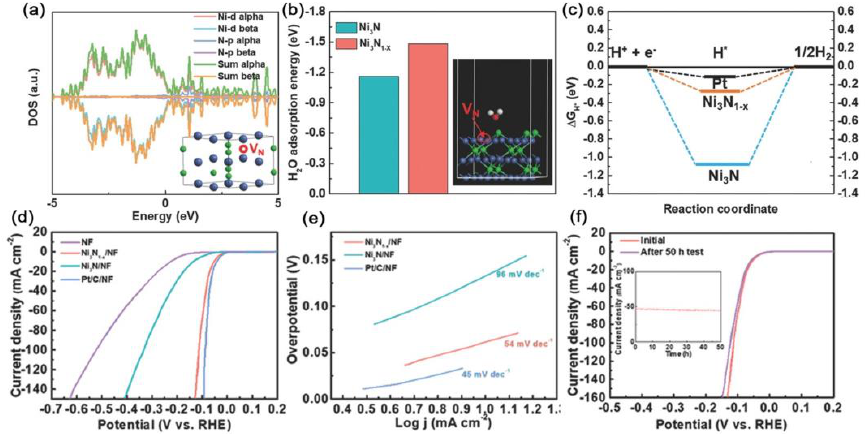
Figure 3. ( a ) The projected electronic TDOS and PDOS of Ni 3 N 1− x . Inset shows the atomic structure model of Ni 3 N 1 − x . The horizontal dashed lines represent the Fermi level (0 eV). ( b ) Partial charge density distribution of Ni 3 N 1 − x . ( c ) The calculated free-energy diagram of HER. ( d ) HER polarization curves measured in 1.0 M KOH solution (pH 14). ( e ) Corresponding Tafel plots. ( f ) LSV curves be- fore and after the stability test for 50 h. Inset shows the chronoamperometry curve. Reproduced with permission from ref. [94]. Copyright 2020, Wiley-VCH.